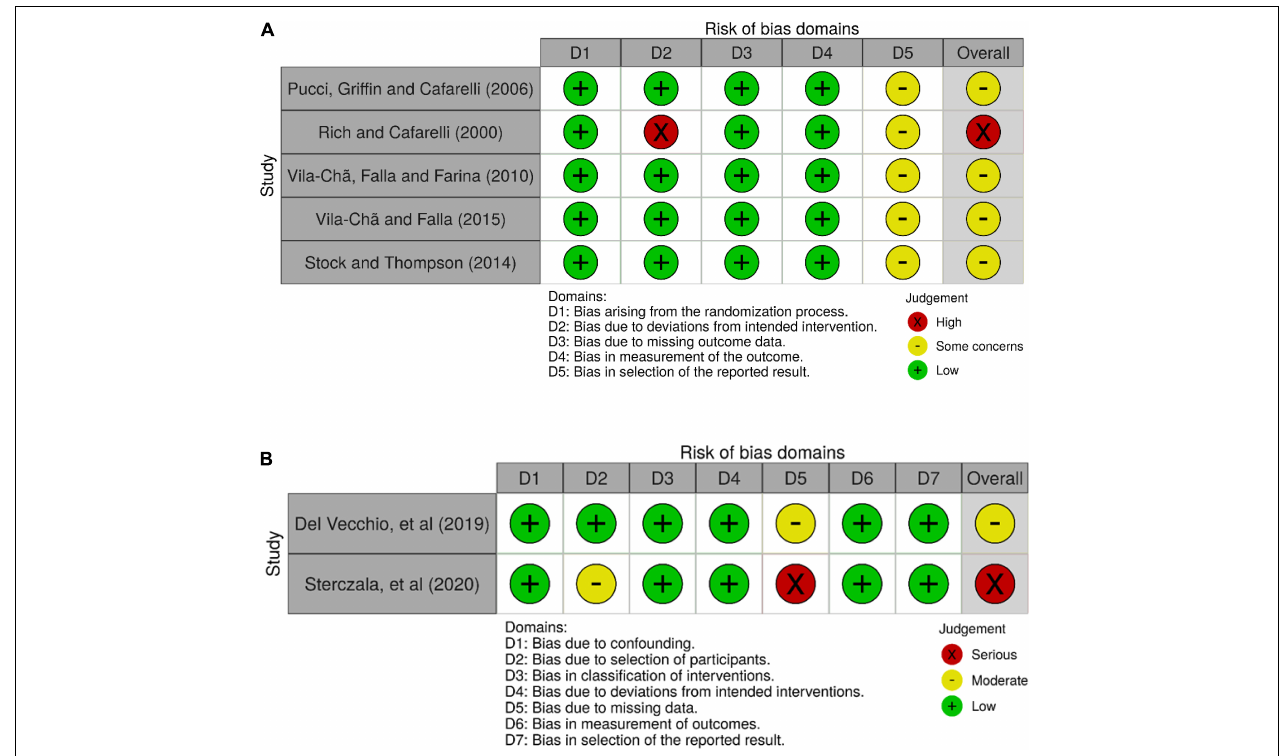
FIGURE 2 | Risk of bias. (A) Results for RCTs, (B) results for NRSIs. *Created using Robvis: McGuinness and Higgins